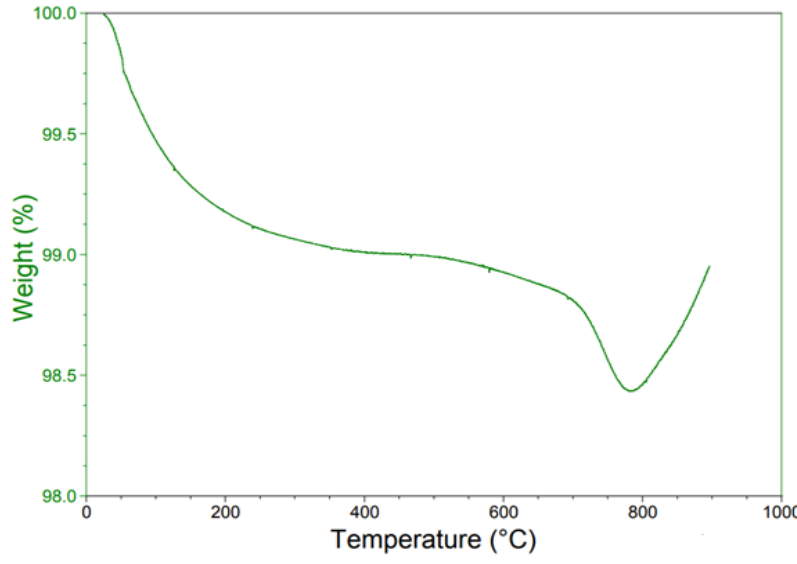
Figure 4. TGA curve of Co 3 O 4 nanoparticles.